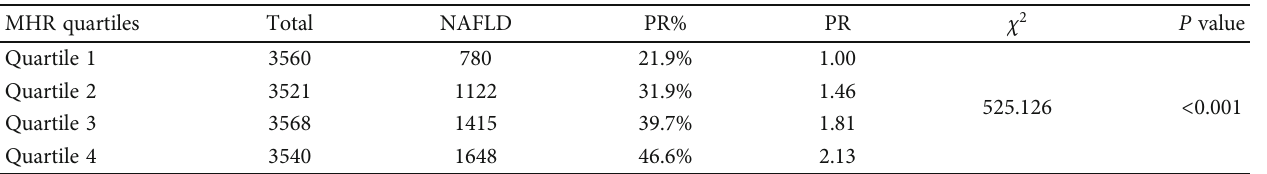
Table 2: Association of MHR with prevalence rate of